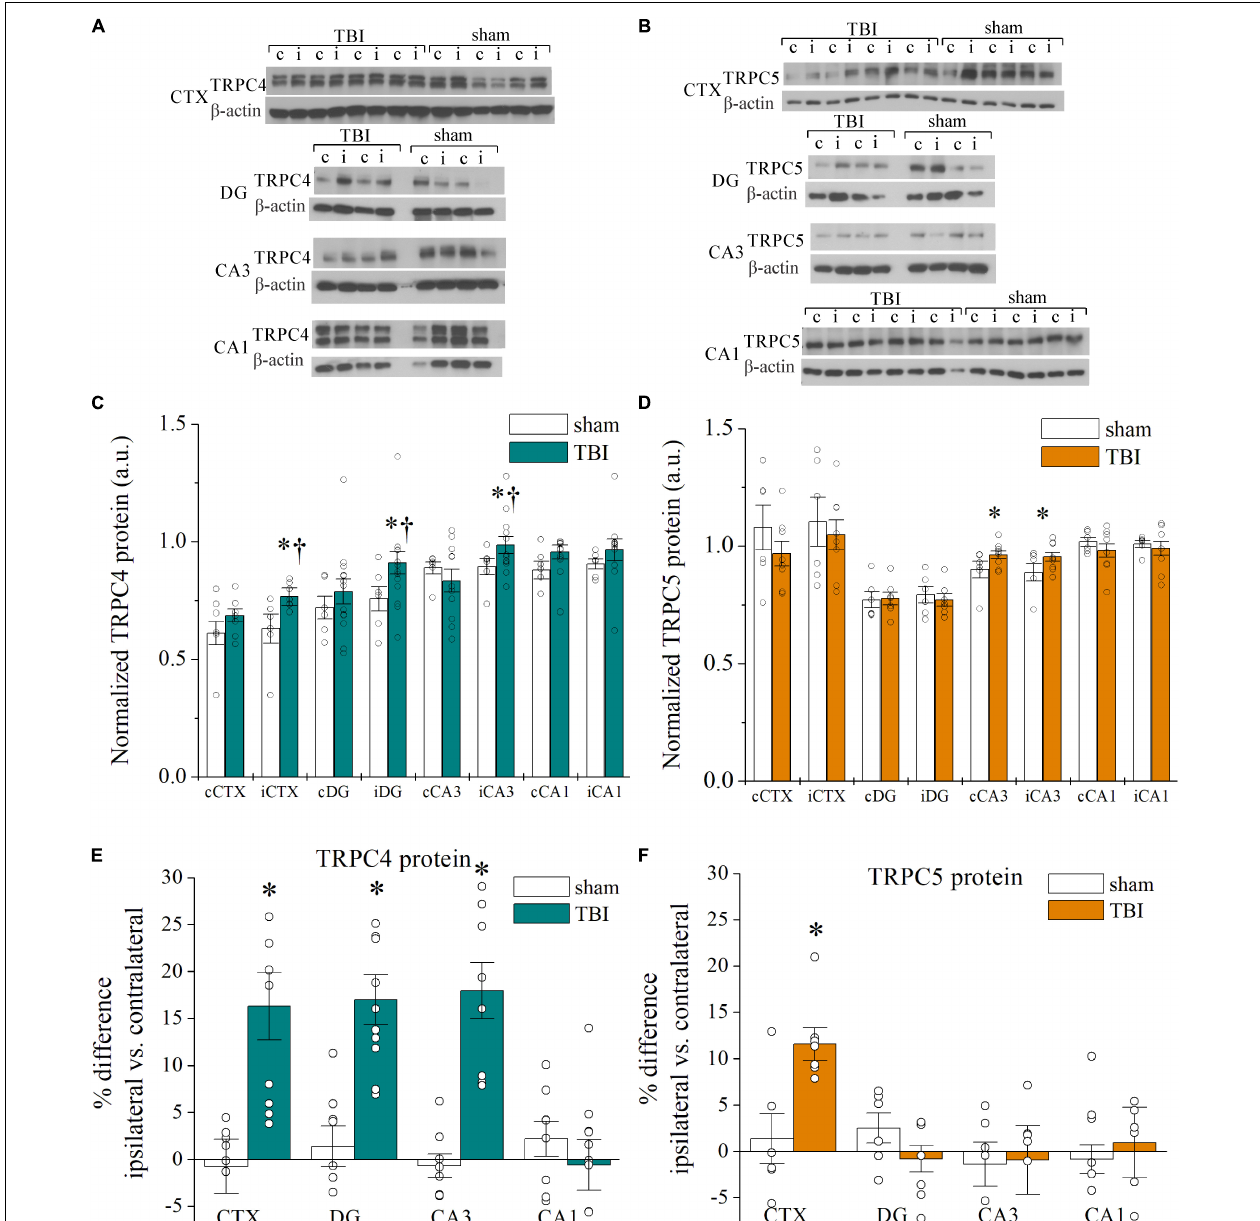
FIGURE 2 | Cell-type specific TRPC1, TRPC4, and TRPC5 channel upregulation in the hippocampus and cortex after CCI-TBI. (A,B) Representative Western immunoblots using (A) TRPC4 ( ∼ 120 kDa) and (B) TRPC5 ( ∼ 110 kDa) antibodies in sham and TBI cortex and hippocampus. Blots were normalized to β -actin protein (42 kDa) as loading control. (C,D) Summarized data for Western blot quantification of TRPC4 ( C , n = 7–13 animals per group ) and TRPC5 ( D , n = 5–7 animals per group) from microdissected brain regions in mice 7 days after TBI. (E,F) Shown are summarized plots of percent difference in TRPC4 (E) and TRPC5 (F) protein between ipsilateral and contralateral hemispheres of microdissected regions from data in Panels (C,D) . All data bars represent the mean ± SEM. * p < 0.05 vs. sham of same subregion. † p < 0.05 vs. contralateral hemisphere of same subregion.